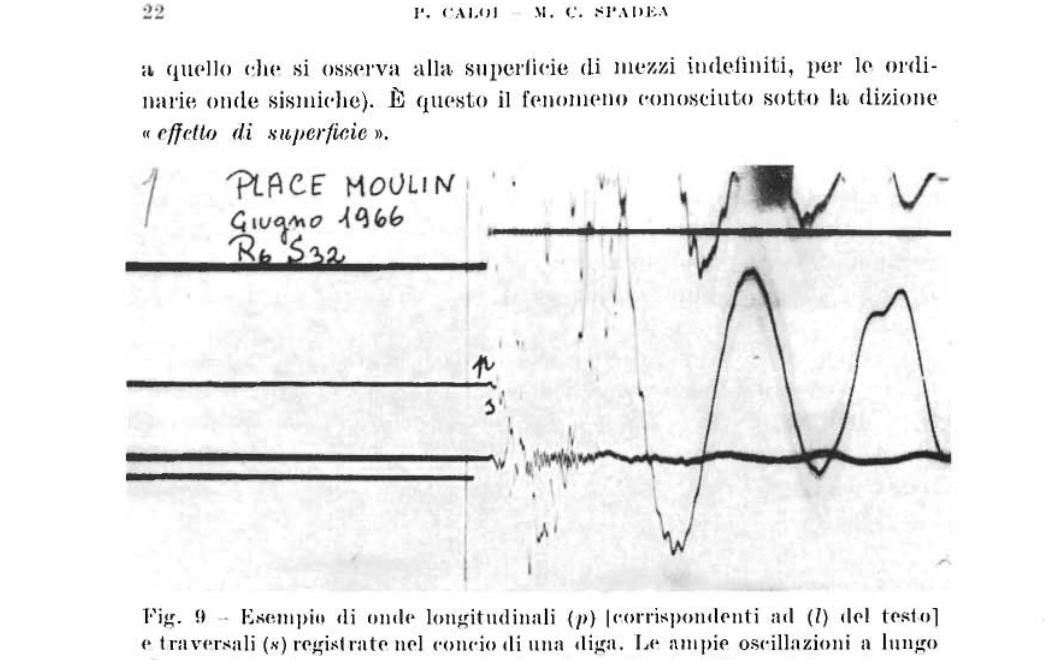
Fig. 9 Esempio di onde longitudinali (p) [corrispondenti ad ( l ) del testo] e traversali (s) registrate nel concio di una diga. Le ampie oscillazioni a lungo periodo che seguono, sono dovute alle oscillazioni libere del concio (vedi paragrafo 4).